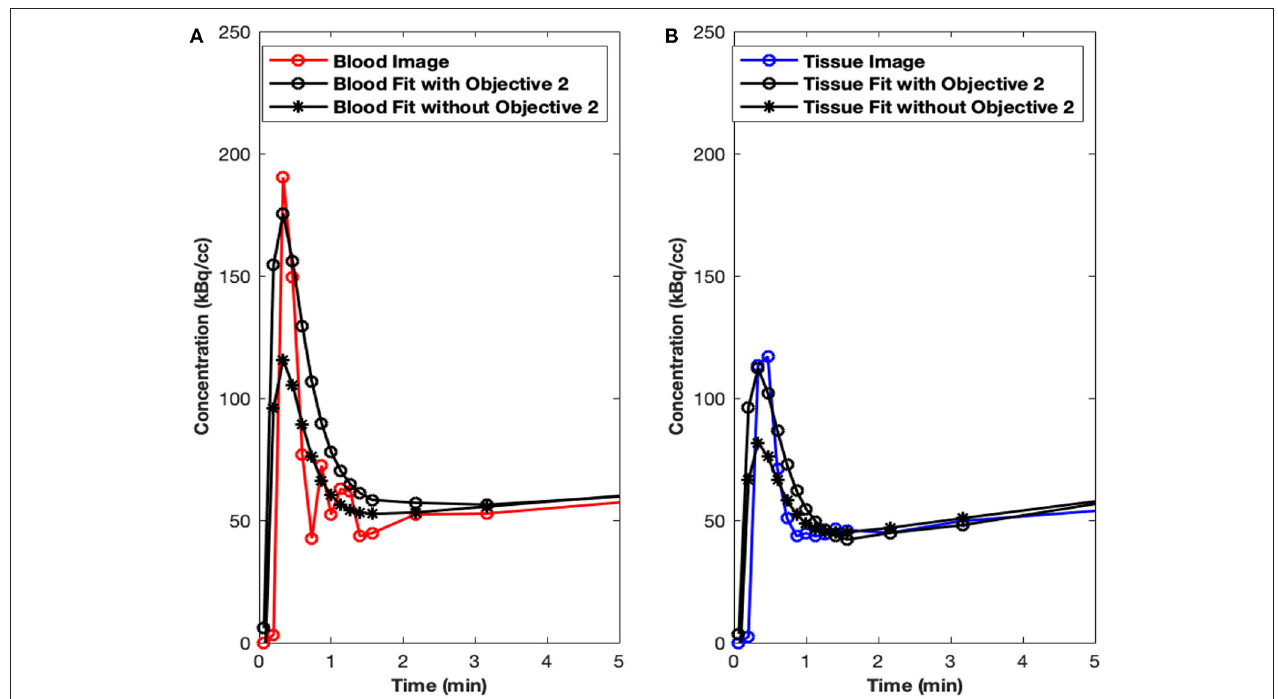
FIGURE 3 | Peak fits with objective function O 2 (p). (A) Peak blood fit with and without the second objective function, O 2 (p) Equation (2). (B) Peak tissue fit with and without O 2 (p).